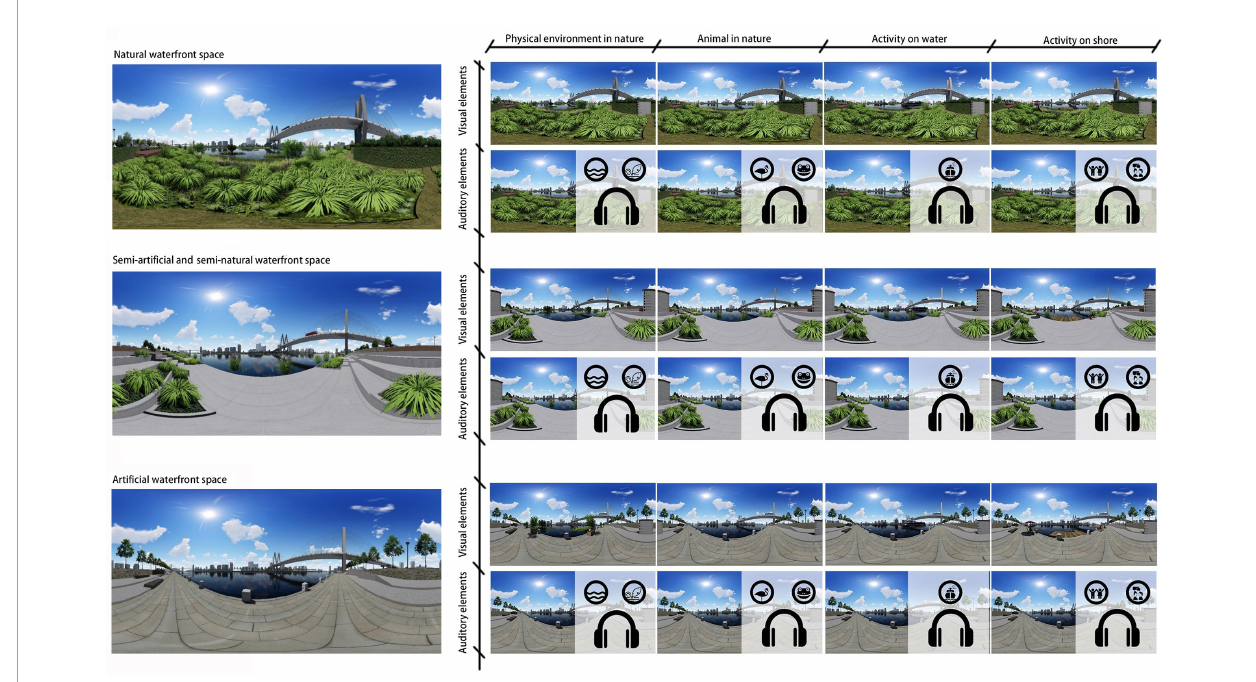
FIGURE3 Experimental stimuli with different audio and visual element